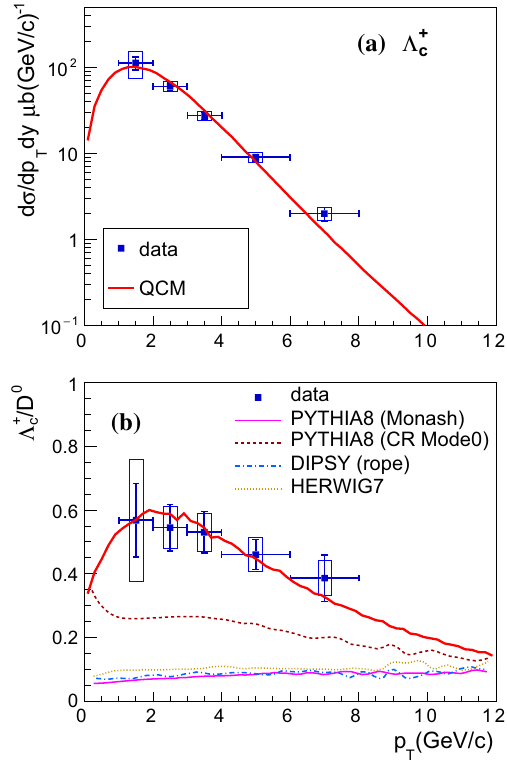
Fig. 4 Differentialcross-sectionof Λ + c atmid-rapidity( a )andtheratio to D 0 ( b )asthefunctionof p T in pp collisionsat are experimental data [9] and the thick solid lines are results of QCM. Results of other models or event generators in panel ( b ) are taken